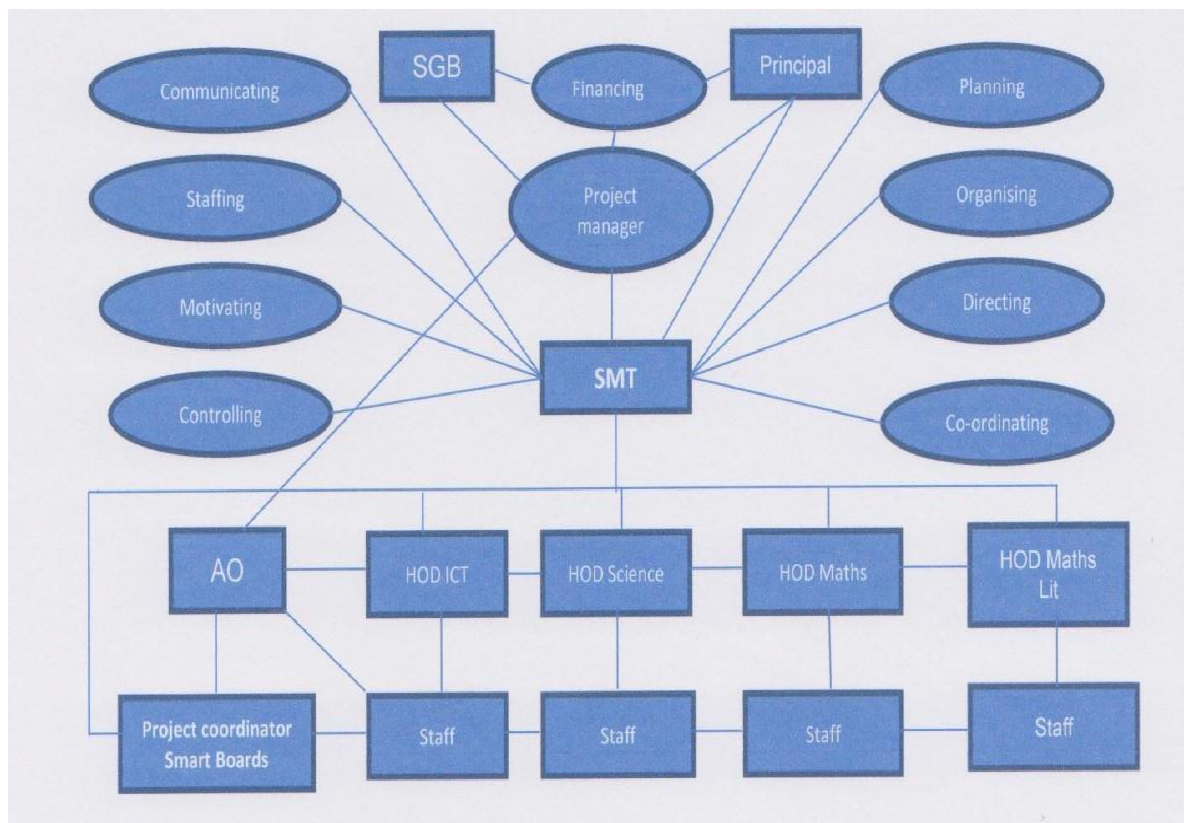
Figure 4 Illustration of the matrix management structure of the ICT project (adapted from Akrani (2010) and Edgell